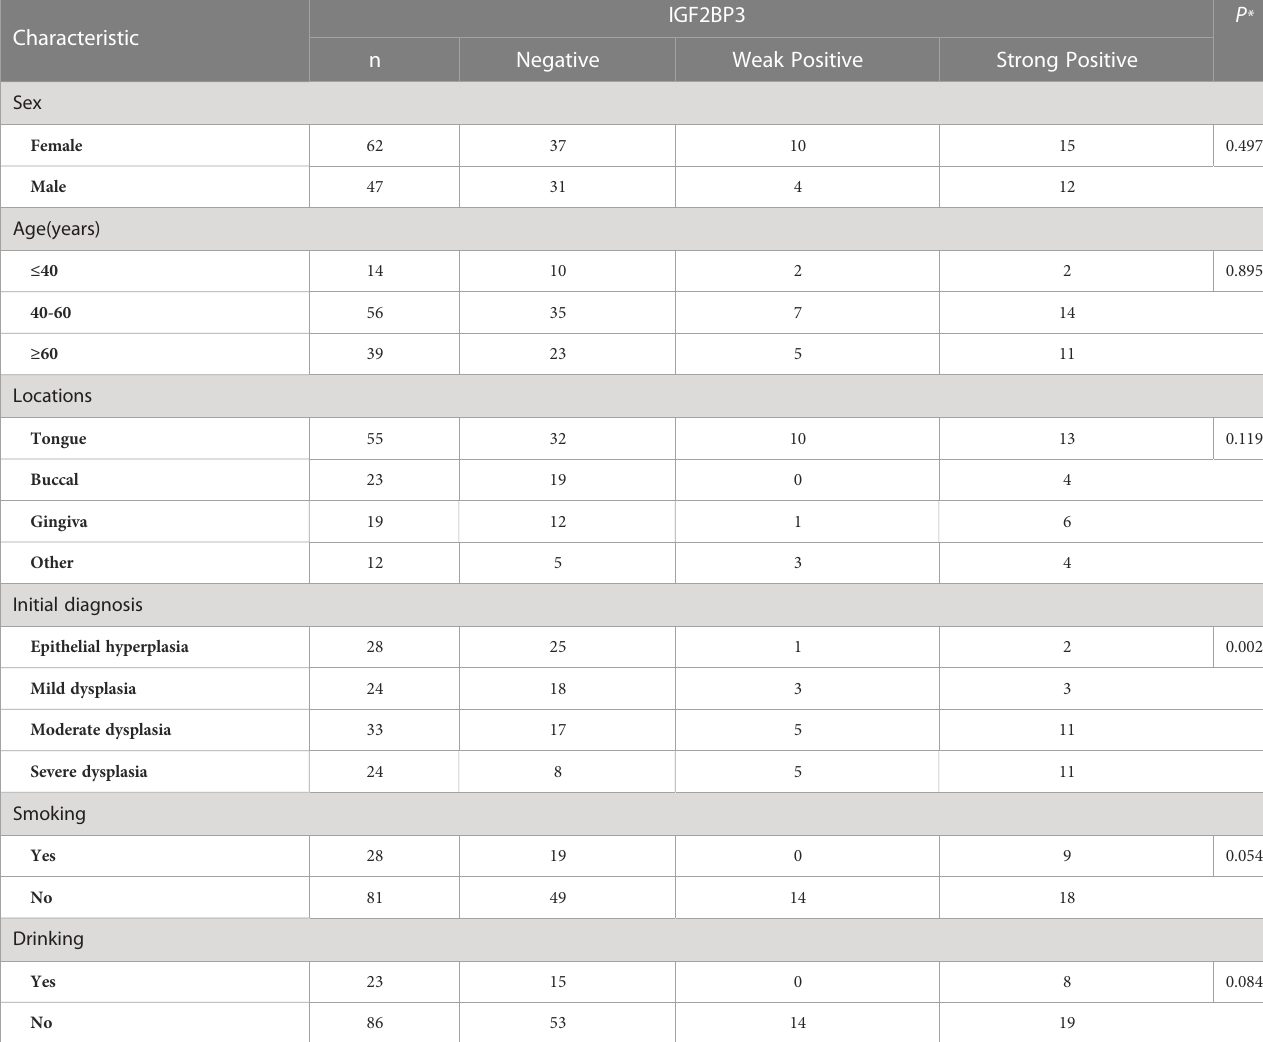
TABLE 5 Association between the clinicopathological characteristics and IGF2BP3 expression in 109 cases of OSCC and OED.